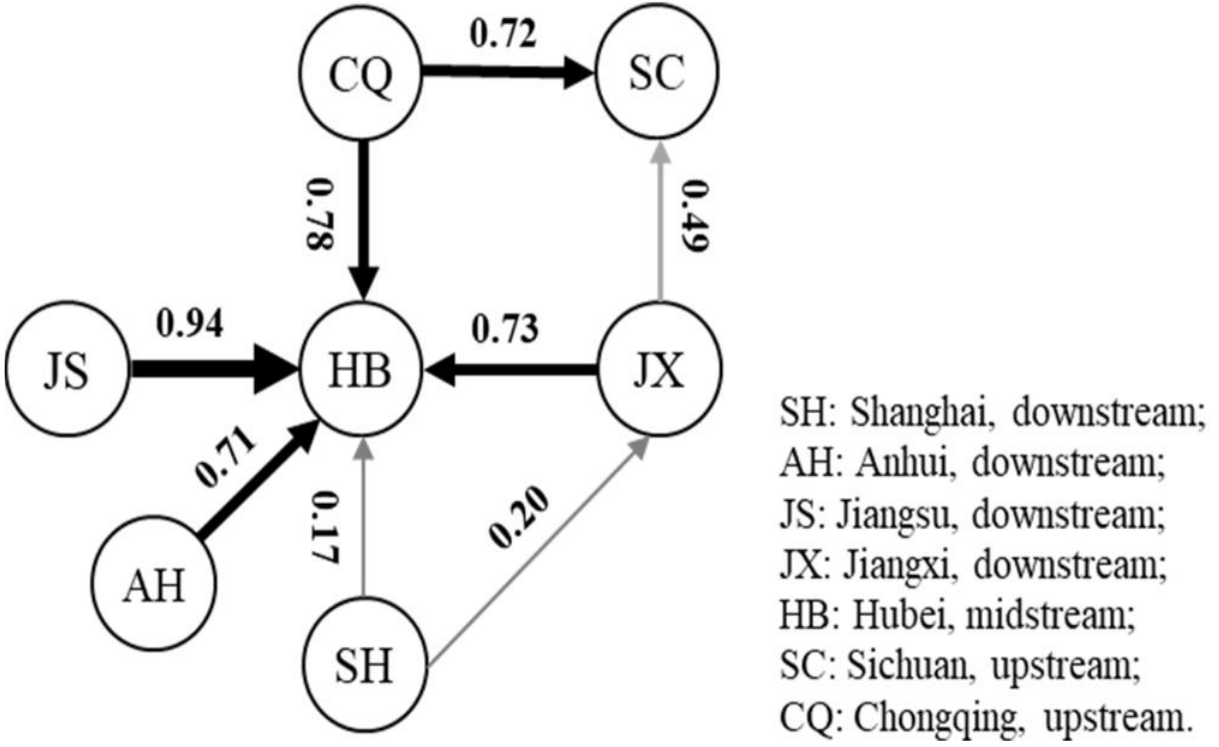
Figure 3. Diffusion analysis of Ae. albopictus population in the Yangtze River Basin based on microsatellite loci. Each circle stands for the Ae. albopictus population, the values (Nm) stand for the gene flow between two populations and the arrows stand for the direction of the gene flow, which varies with the gene flow value; the diffusion routines with Nm value greater than 0.2 are displayed.